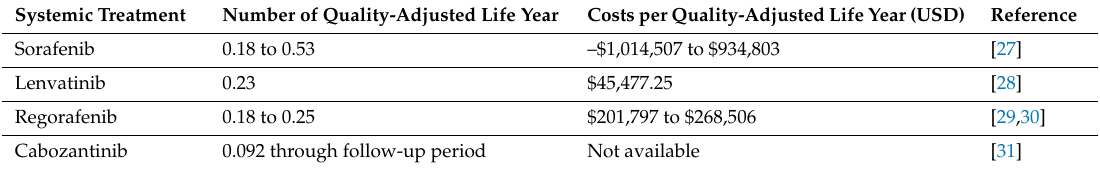
Table 2. Cost e ff ectiveness data of systematic treatments.